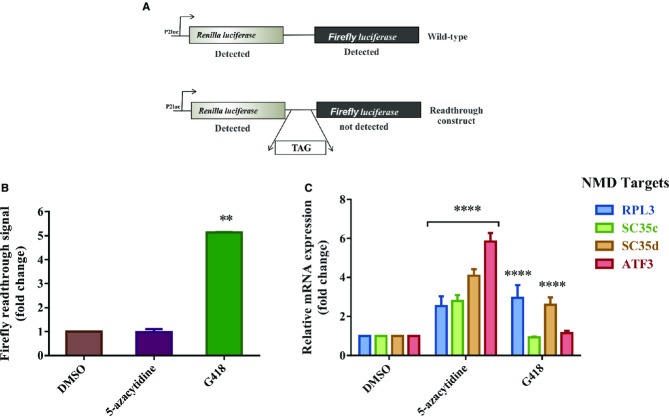
5-azacytidine does not inhibit NMD via a readthrough mechanismSchematic representation of the readthrough reporters. The open reading frames of the renilla and
firefly luciferase genes are separated by a spacer that either contains or does not contain a TAG
stop codon. In case of the absence of the stop codon both, renilla and firefly luciferase
luminescence are detected, while in the presence of the stop codon, the firefly luciferase signal is
detected only when there is sufficient translational readthrough.Assay of translational readthrough of HeLa cells that were transiently transfected either with
the reporter with or without the stop codon. 24 h following transfection, the cells were
treated for 18 h with DMSO (negative control), 5-azacytidine or G418 (600 μM;
positive control). After 18 h, cells were harvested and chemiluminescence was measured. The
data are shown as fold change of the ratio of firefly/renilla luciferase signal of the construct
with the stop codon after normalization of the renilla and firefly luciferase signals generated by
the reporter construct without the stop codon. Student's t-test was
performed to analyze significance, N = 3 and
**P = 0.0017 for G418. Each bar represents
average ± SD.qRT-PCR analysis of the endogenous NMD targets RPL3, SC35c, SC35d and ATF3 in the same cells that
were assayed for translational readthrough in panel (B). The fold change on the
y-axis represents the relative quantification of transcripts following
normalization against GAPDH mRNA. The signal detected in DMSO-treated cells is set as 1. Two-way
ANOVA followed by Newman–Keuls multiple comparison test was performed to analyze the
significance, N = 3 and
****P < 0.0001 for RPL3, SC35c,
SC35d and ATF3 with 5-azacytidine treatment and
****P < 0.0001 for RPL3 and SC35d
with G418 treatment. Each bar represents average ± SD.